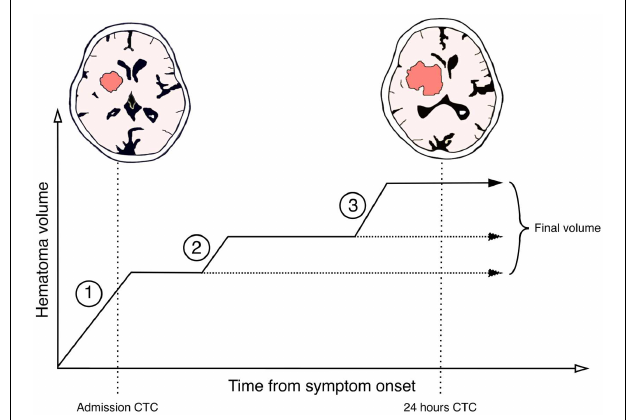
FIGURE 1 | Suggested schematic model for a step-wise hematoma expansion-profile in intracerebral hemorrhages . Phase 1 represents the initial active bleeding-period most likely caused by the originally ruptured vessel. If patients are admitted within this phase an active hemorrhage will still be occurring post-admission and instant expansion can be observed. After phase 1 a plateau-phase might exist in which the hematoma volume is constant or active bleeding occurs slowly. In some patients, this phase might represent the final hematoma volume (horizontal stippled line). Phase 2 represents a secondary bleeding-period.This is likely due to secondary vessel rupture caused by pressure and ischemia on adjacent tissue structures or by re-bleeding from the originally ruptured vessel. Some patients might have multiple secondary bleeding-periods and some even late (phase 3). Between these periods are interpolated plateau-phases with relative constant hematoma volume or slow active bleeding.This results in